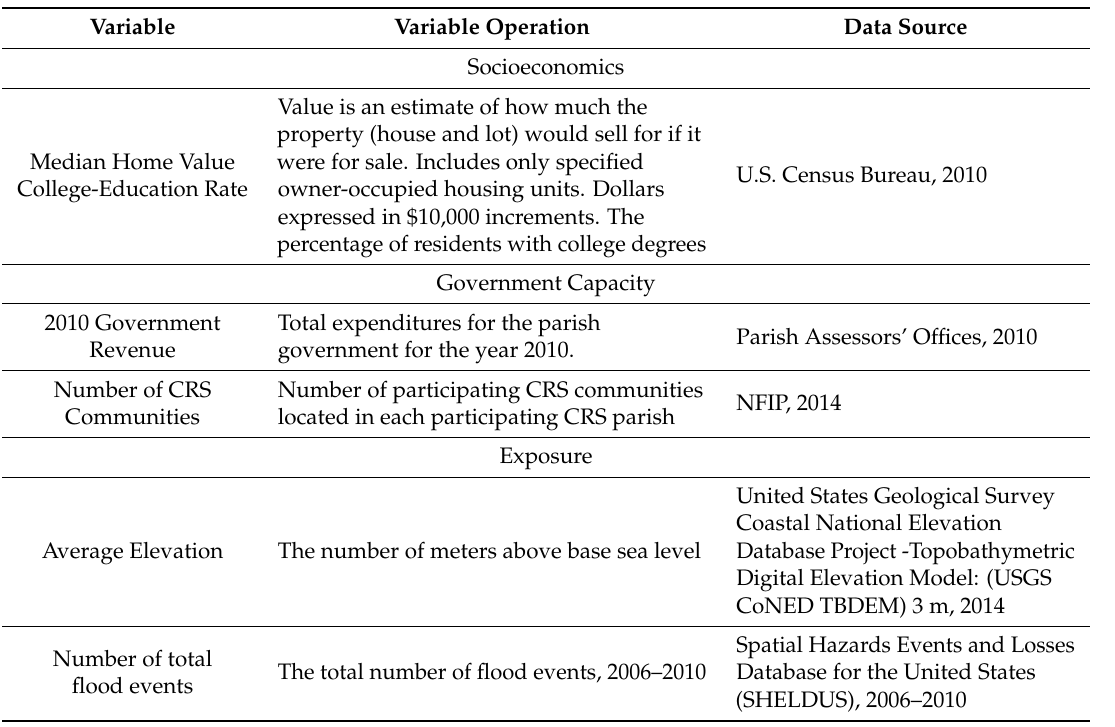
Table 4. Independent